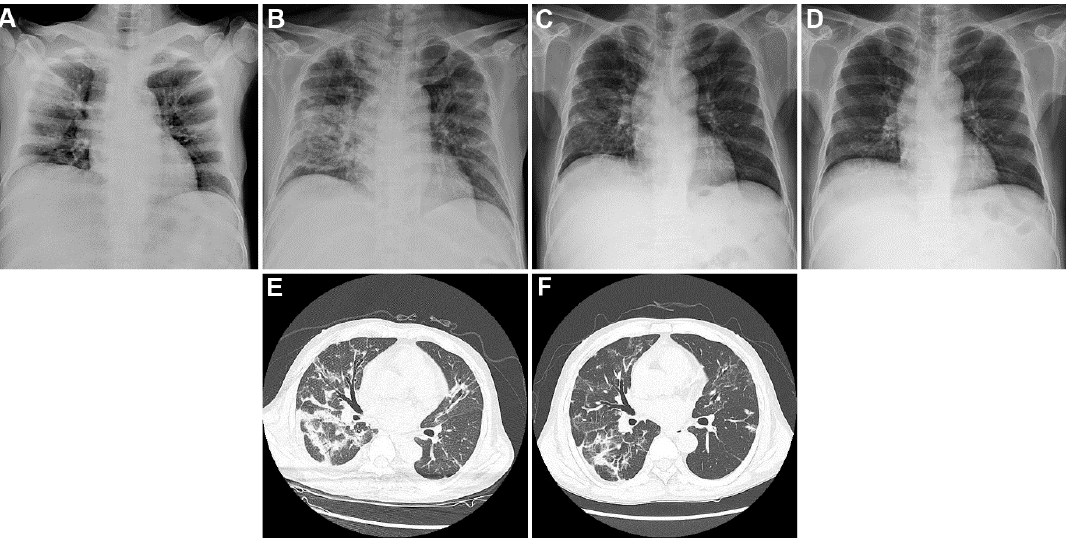
Figure 2. Temporal changes in chest imaging studies in one patient with end-stage renal disease and COVID-19. Temporal changes in chest radiography and computed tomography for patient number 2. Initial chest radiography upon admission showed focal consolidations in the right upper and left middle lung zones ( A ). ( B , E ) Images obtained on the 16th day of hospitalization showed bilateral worsening of multifocal patchy consolidations and ground glass opacities. ( C , F ) Images obtained on the 23rd day of hospitalization (the day of discharge) showed improvement of multifocal patchy consolidations and ground glass opacities, as well as organized changes. ( D ) Image obtained on 14th day after discharge (37 days from admission) showed resolved inflammatory lung lesions.